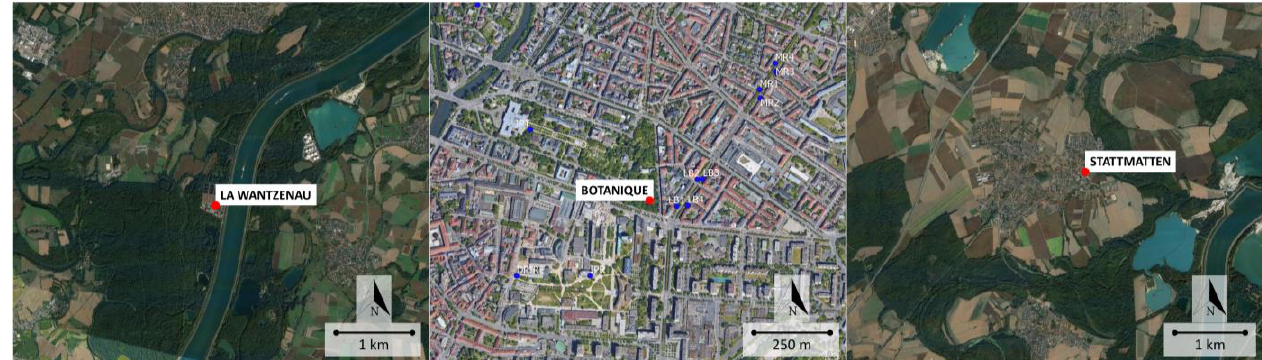
Figure 9. Locations for which maximum absolute error between LST and air temperature were obtained. Source: